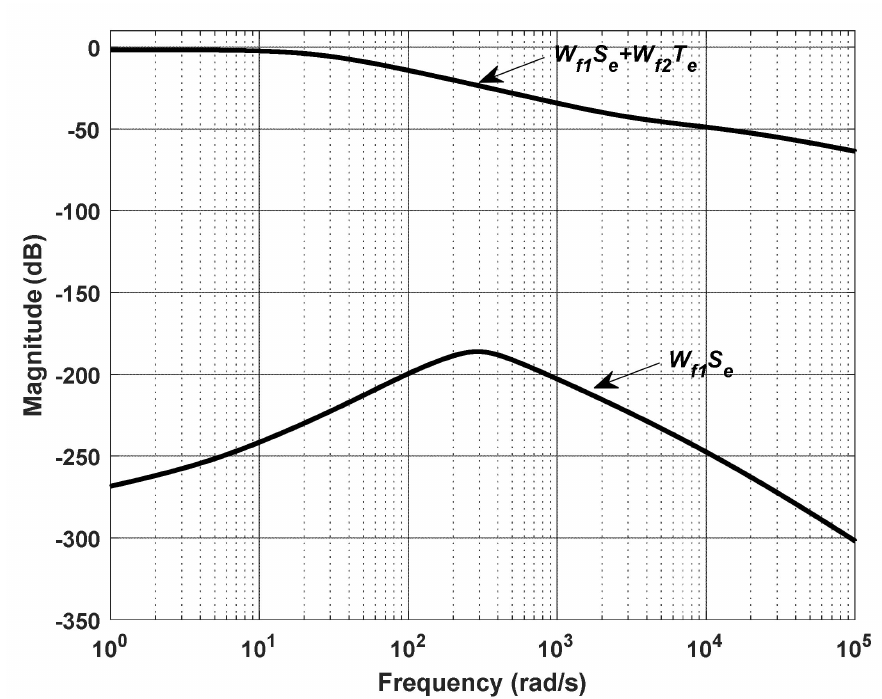
Figure 11. The nominal and robust performance